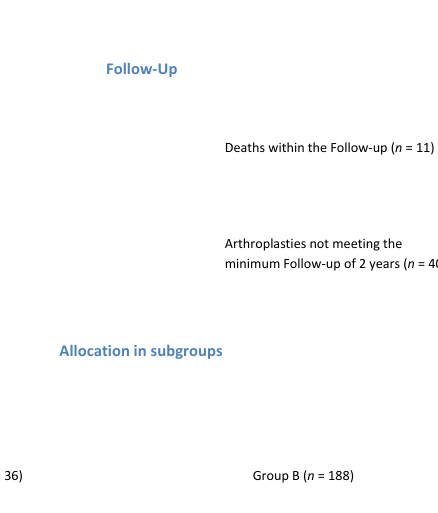
Figure 1. Flowchart regarding formation of the study population and its allocation in the two study subgroups dependent on the patient’s age at time of surgery (Group A = age under 50 years; Group B = age above 50 years).